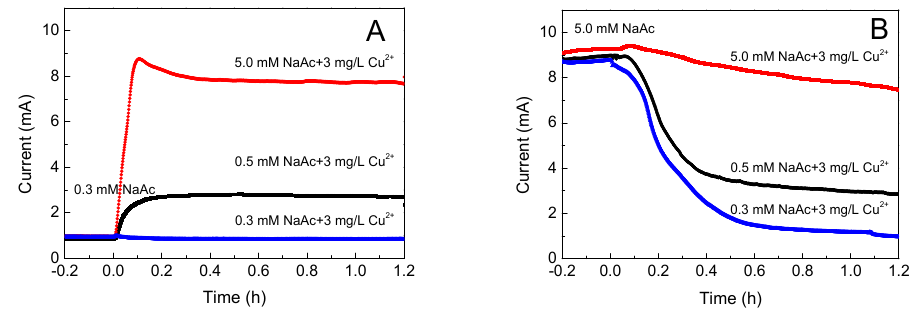
Figure 3. The signal interference of an MFC sensor by the combined shock of biochemical oxygen demand (BOD) and toxicity in a continuous flow-through mode: ( A ) the MFC sensor operated with background acetate of 0.3 mM; ( B ) the MFC sensor operated with background acetate of 5 mM.